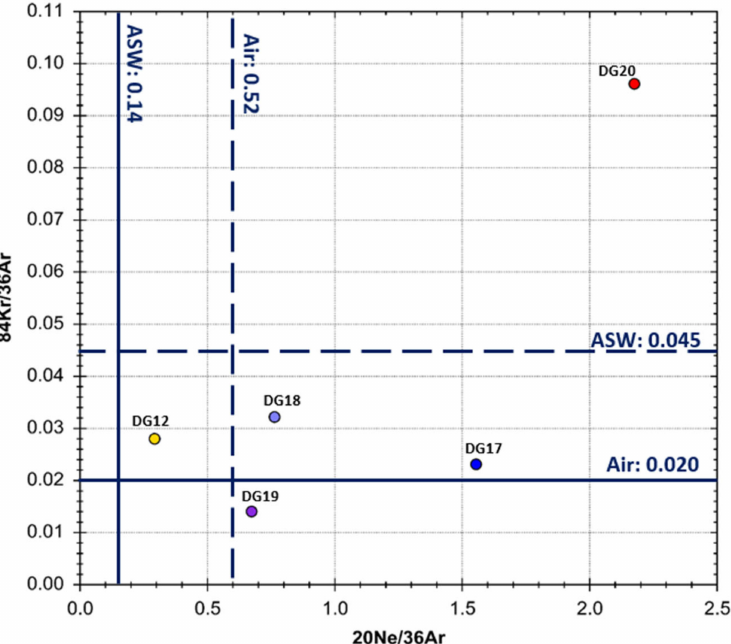
Figure 12. Plot of 20 Ne/ 36 Ar versus 84 Kr/ 36 Ar for five selected Marcellus Formation dry produced gases collected in northeastern Pennsylvania. Four of the gas samples lie near to air and ASW values for 84 Kr/ 36 Ar indicating gas/water phase equilibrium [44–47]. Samples DG17 and DG20 show higher fractionation in 20 Ne/ 36 Ar. 20 Ne concentrations are strongly dependent on thermal maturity. Sample DG20 exhibits extreme fractionation of 84 Kr/ 36 Ar which may be due to release of atmosphere-derived Kr originally adsorbed and trapped in organic-rich sediment [48–50] or to non-equilibrium diffusion